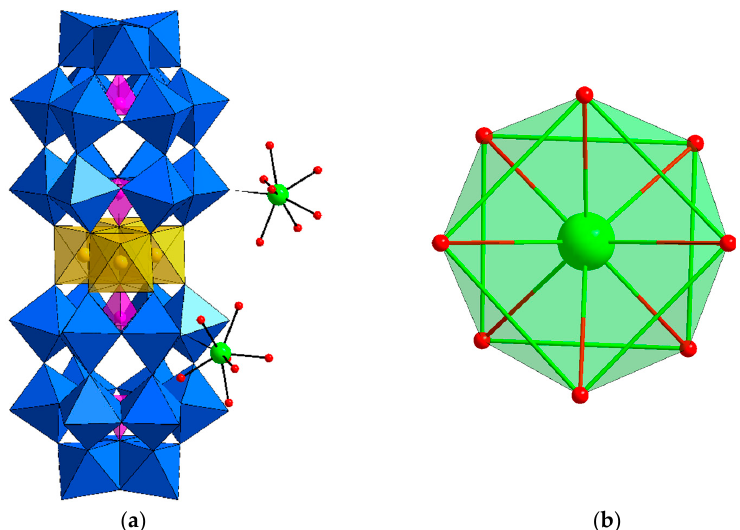
Figure 1. ( a ) Polyhedral and ball-and-stick representation of the sandwich-type polyanion and the dysprosium cations of Dy 2 Mn 4 -P 2 W 15 ; ( b ) Local geometry around the dysprosium cation in Dy 2 Mn 4 -P 2 W 15 , possessing a square antiprism geometry. Color scheme: Dy = green; O = red; WO 6 octahedron = blue, MnO 6 octahedron = gold; PO 4 tetrahedron = Pink.